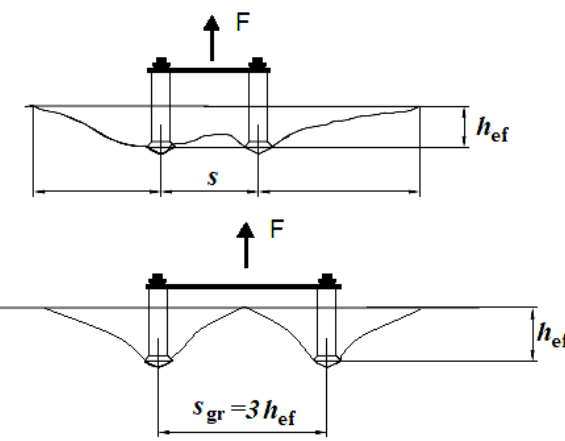
Figure 1. The group effect in cone failure relative to anchor spacing s —a system of 2 anchors.